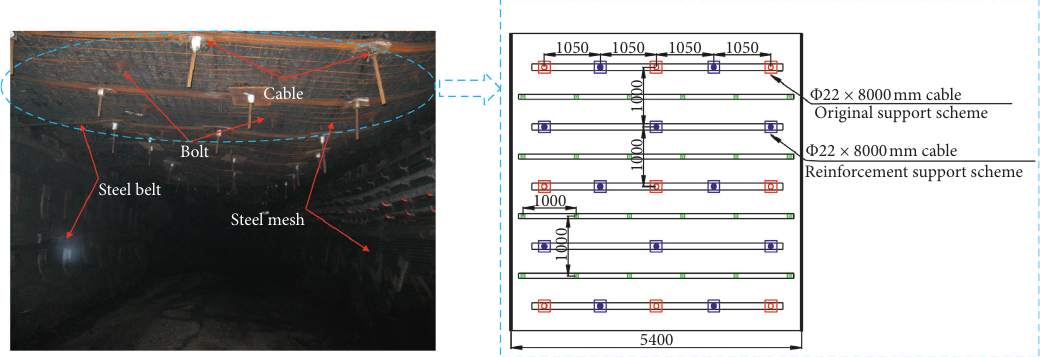
Figure 16: Reinforcement support parameter of roadway roof.